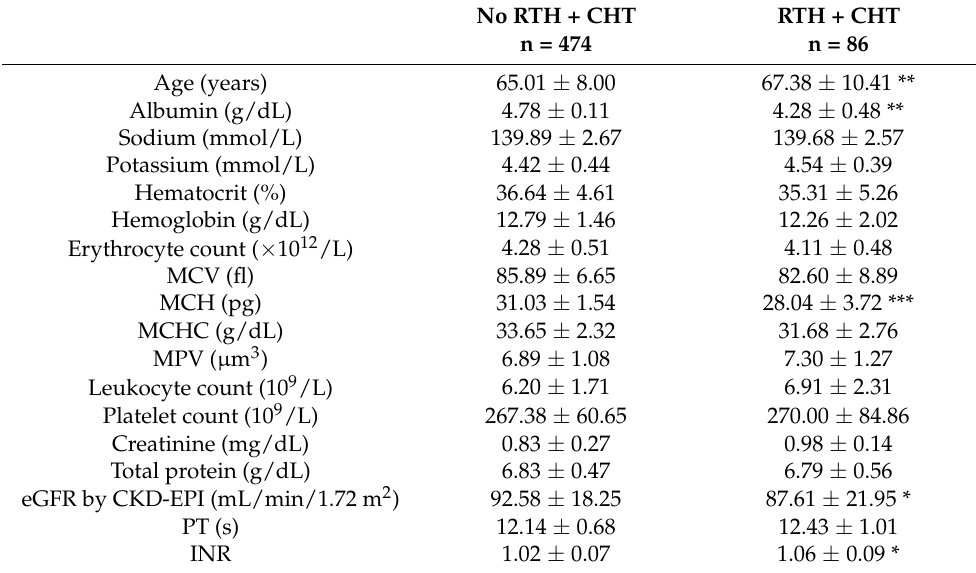
Table 3. Clinical and biochemical data of colorectal cancer patients in regard to neoadjuvant